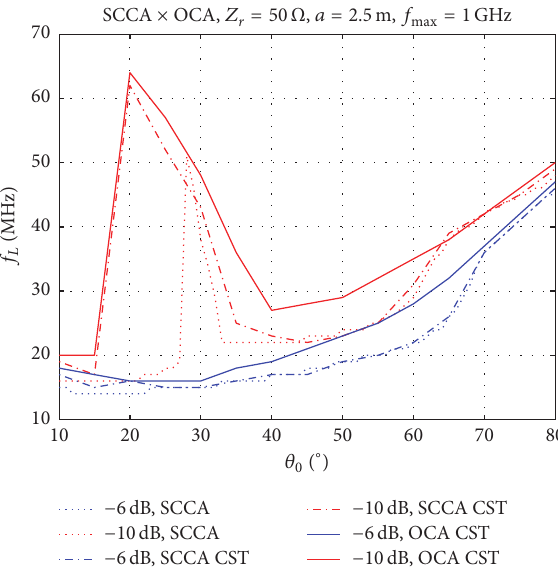
Figure 15: 𝑆 11 of the theoretical SCCA and the CST simulated SCCA and OCA for 𝜃 0 = 45 ∘ and 𝑍 𝑟 = 50 Ω .